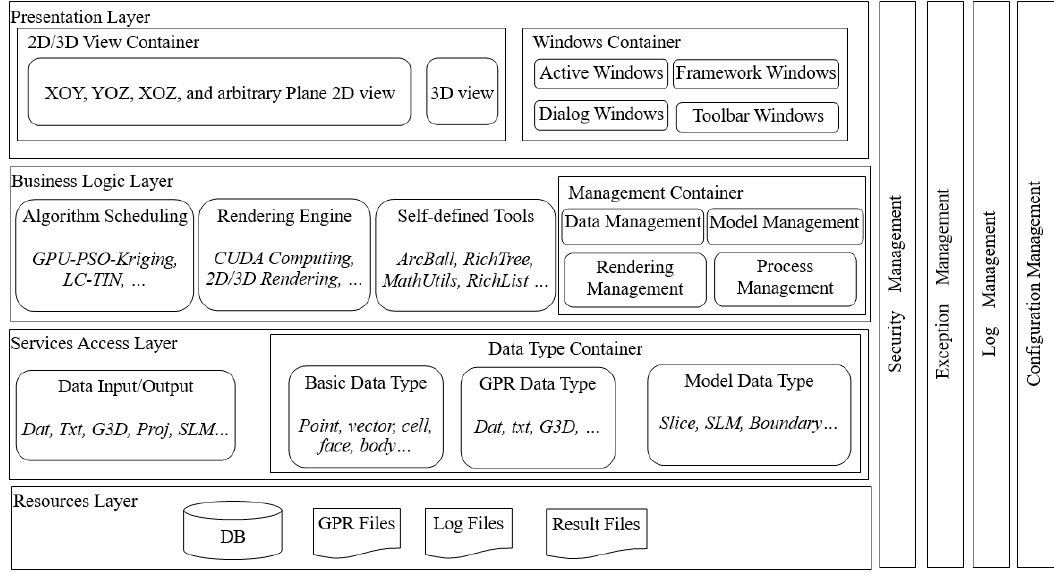
Figure 2. The architecture of 3DVF4UDR.